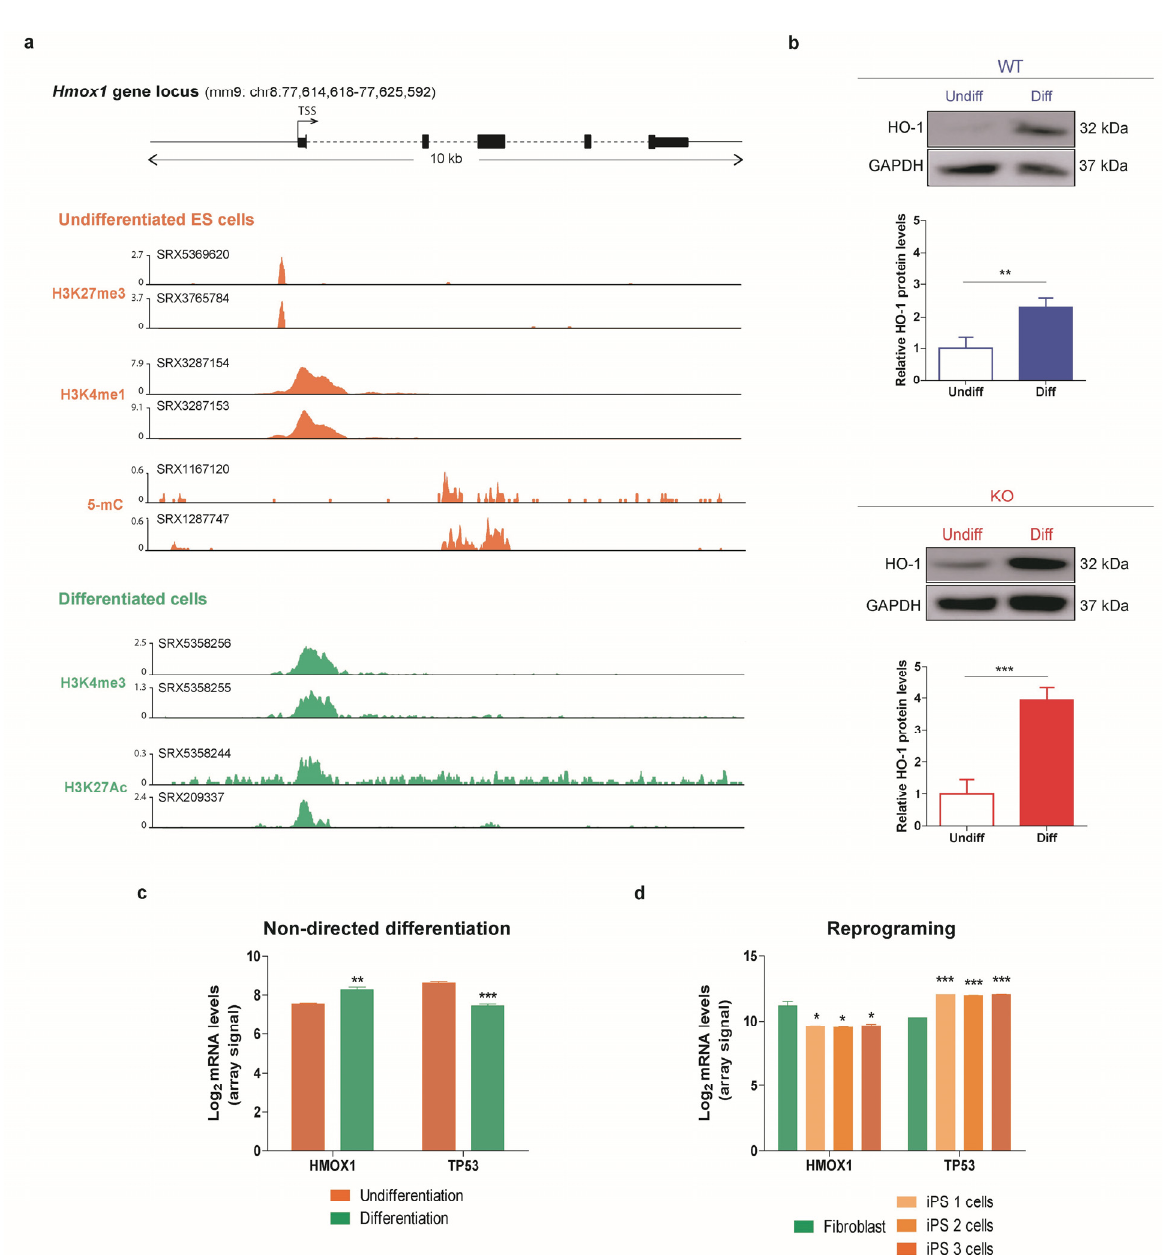
Figure 5. HO-1 increases during differentiation in WT and p53 KO ES cells. ( a ) Analysis of the indicated histone modifications and Cytosine methylation (5-mC) present in Hmox1 locus in undifferentiated ES cells and ES cells subjected to differentiation protocols (differentiated cells) using the public ChIP-seq data available in Chip Atlas data-mining platform. Dataset identification numbers of each experiment are shown at the top of the y-axis. ( b ) WT and KO ES cells were induced to differentiate by 2i/LIF withdrawal for 2 days (Diff) and HO-1 protein levels were evaluated by Western blot. Upper panels show representative blots. GAPDH was used as loading control. Lower panels show HO-1/GAPDH band densitometry relative to the control condition (Undifferentiated). Bars represent the mean ± SEM of three independent experiments. Asterisks indicate significant differences when compared to the control condition (Undifferentiated) (**, p < 0.01; ***, p < 0.001). ( c ) Microarray data analysis of HMOX1 and TP53 gene expression in undifferentiated human ES and in human ES cells subjected to a non-directed differentiation protocol. ( d ) Microarray data analysis of HMOX1 and TP53 gene expression during human fibroblast reprograming into iPS cells. Bars represent the mean ± SEM of each experiment. Asterisks indicate significant differences between undifferentiated (orange) and differentiated (green) cells (*, p < 0.05; **, p < 0.01; ***, p < 0.001).